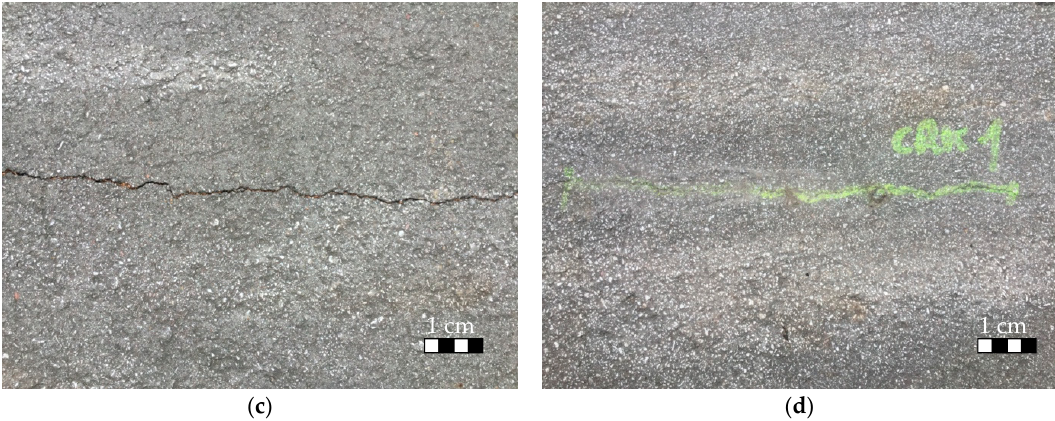
Figure 13. ( a ) Illustration of real-scale test section microwave-assisted asphalt pavement repair (cores were taken from nearby locations), core from the pavement before MW treatment; ( b ) Core from the pavement treated with MW; ( c ) Cracked pavement before MW repair (crack width ca. 5 mm, crack depth–12 cm, full pavement depth, ( d ) Cracked pavement after MW repair.